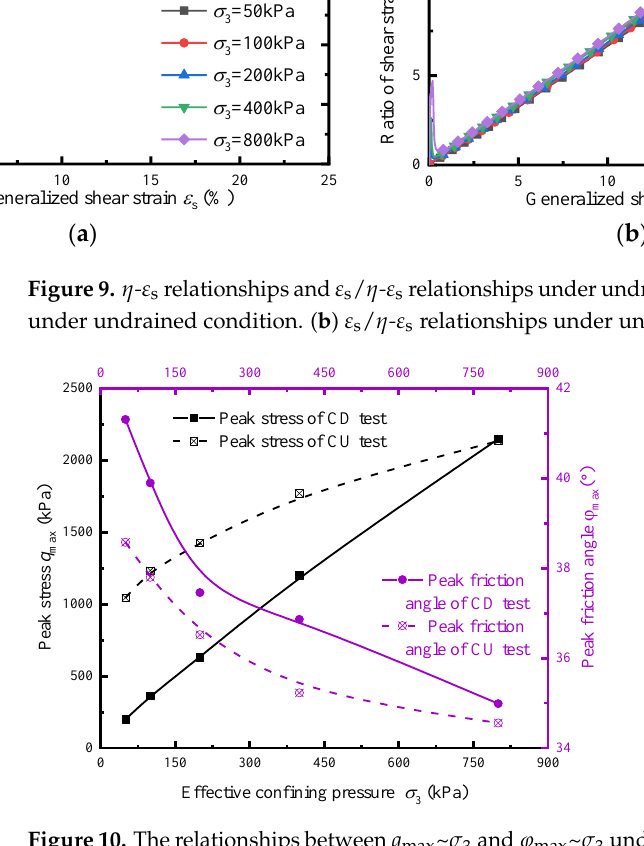
Figure 10. The relationships between q max ~ σ 3 and φ max ~ σ 3 under drained and undrained conditions.